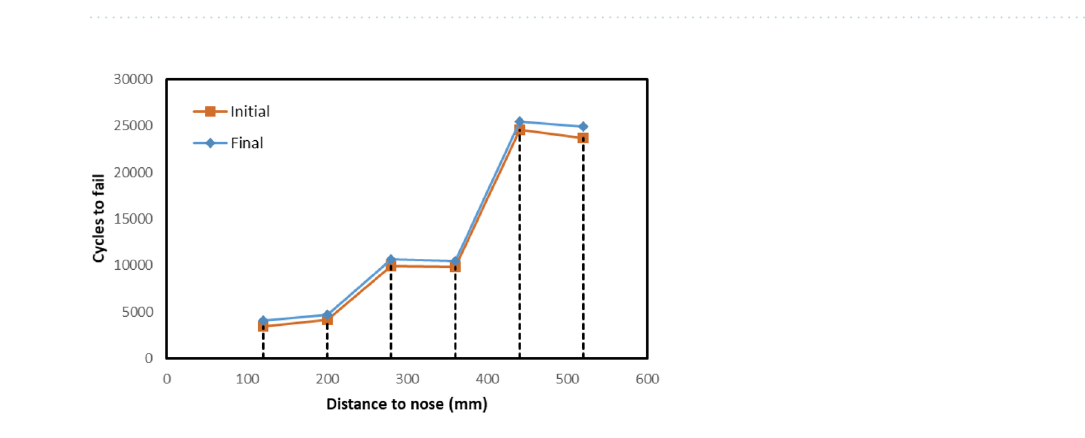
Figure 16. Development of a crack due to contact forces.